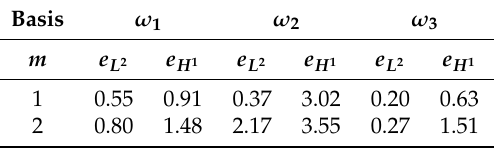
Figure 9. Exact multiscale basis functions φ ω 3 m ( left ), predicted multiscale basis functions φ ω 3 ,pred m ( middle ) and their differences ( right ) in the coarse neighborhood ω 3 in experiment 2. The first row and the second row illustrate the first basis function φ ω 3 and the second basis function φ ω 3 , respecitvely. 2 1 Table 5. Mean percentage error of multiscale basis functions φ ω i m in experiment 2.